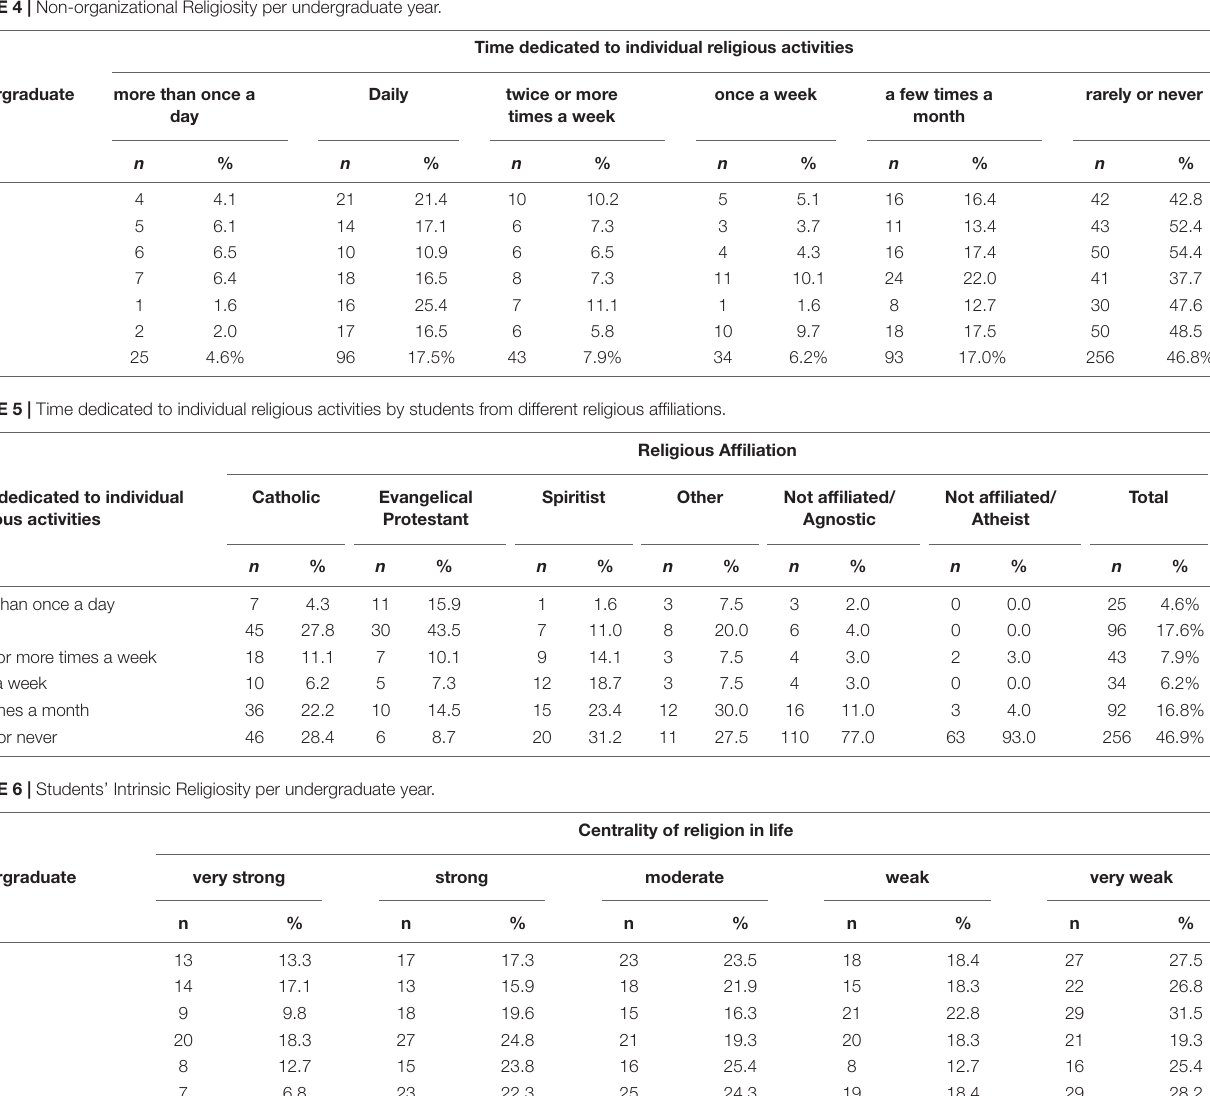
TABLE 4 | Non-organizational Religiosity per undergraduate year.